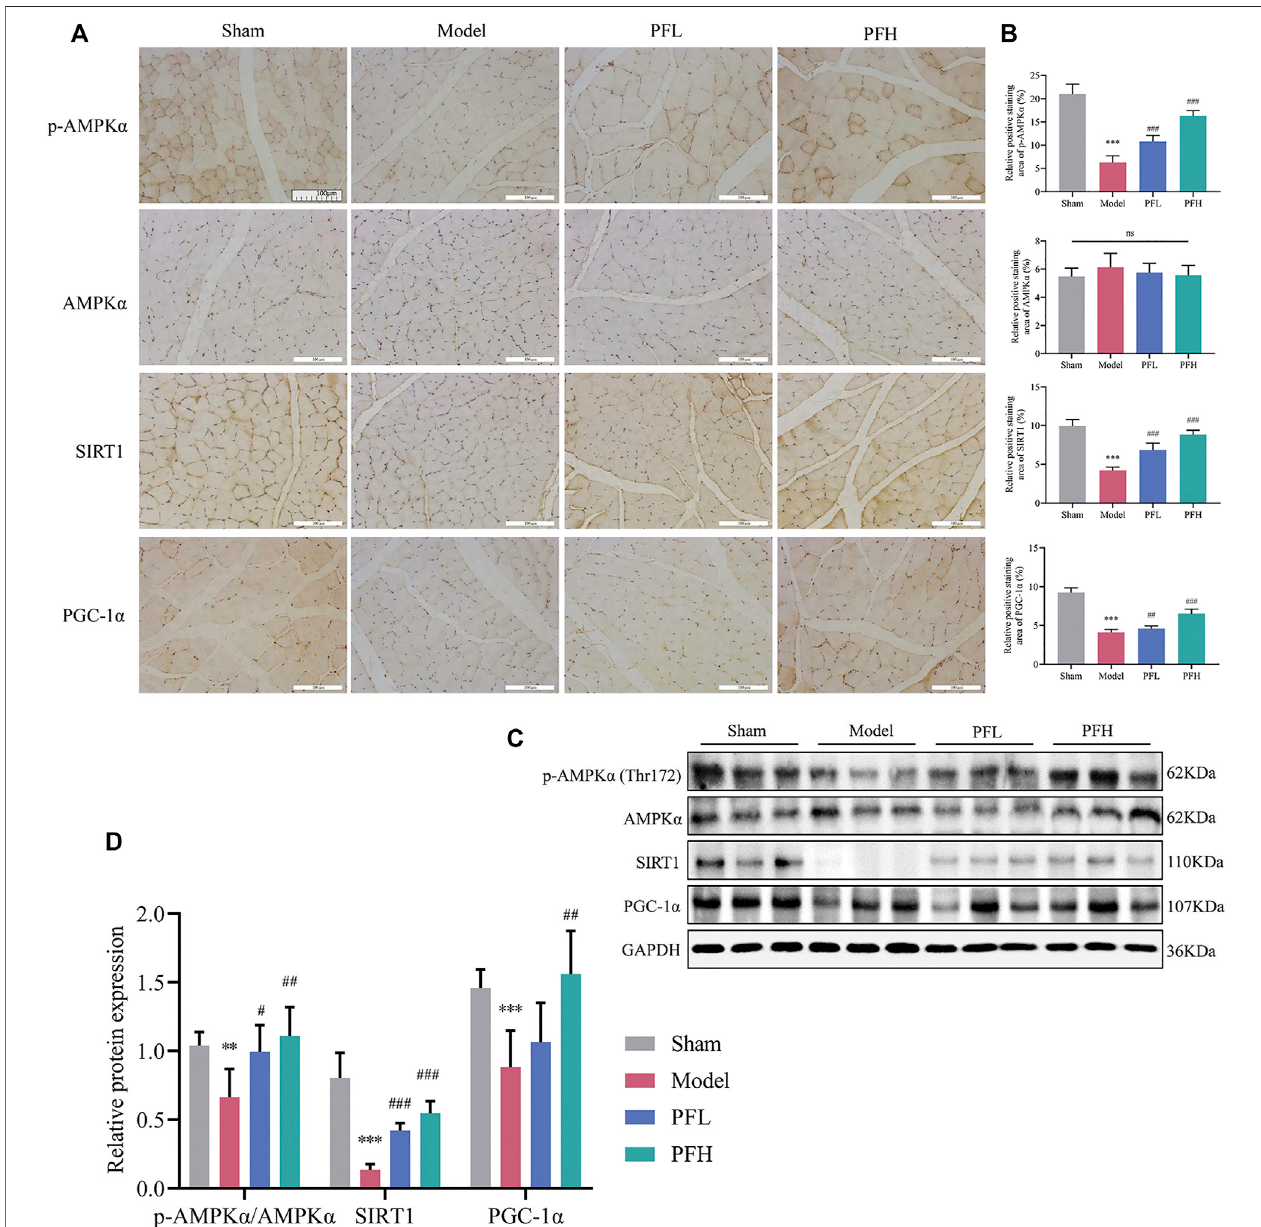
FIGURE 5 | PF enhanced the expression of p-AMPK α , SIRT1, and PGC-1 α in the muscles of CKD model rats. (A) Representative images of p-AMPK α , AMPK α , SIRT1, and PGC-1 α expression in the TA muscles of rats using immunohistochemical (IHC) staining (magni fi cation: ×200 scale bars: 100 µm). (B) The positive staining areas of p-AMPK α , AMPK α , SIRT1 and PGC-1 α were compared between all groups ( n = 10). (C) Representative immunoblots using antibodies against p-AMPK α (Thr172),AMPK α ,SIRT1,PGC-1 α andGAPDH. (D) Proteinexpressionofp-AMPK α /AMPK α ,SIRT1andPGC-1 α .Theproteinexpressionwasnormalizedtothatof GAPDH as a loading control ( n = 6). All of the data are expressed as the means ± S.Ds. Signi fi cantdifferences are indicated as * p < 0.05, ** p < 0.01, *** p < 0.001 vs. the Sham group. # p < 0.05, ## p < 0.01, ### p < 0.001 vs. the Model group.